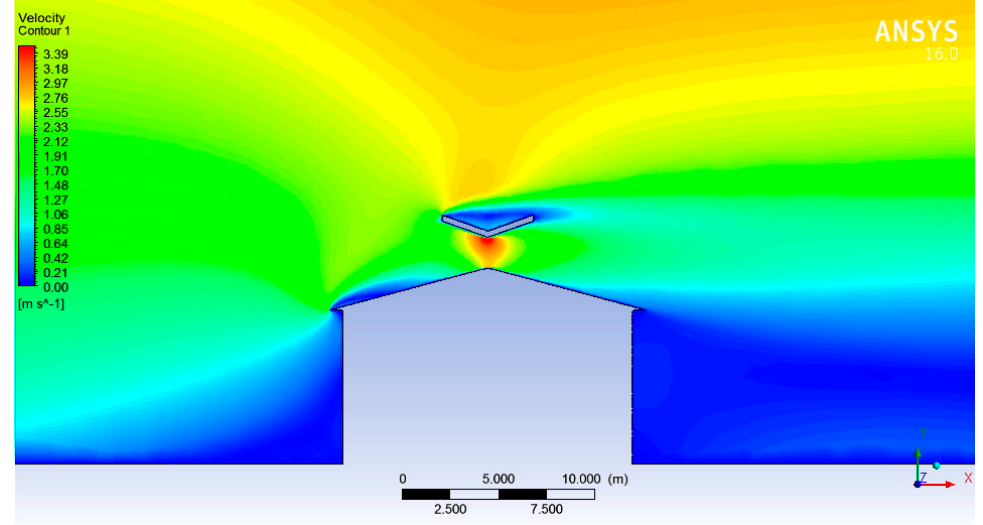
Figure 9. Wind velocity contour distribution for the VRGV with pitch angle 19.5°. Reprint with permission [46]; 2018, Springer.